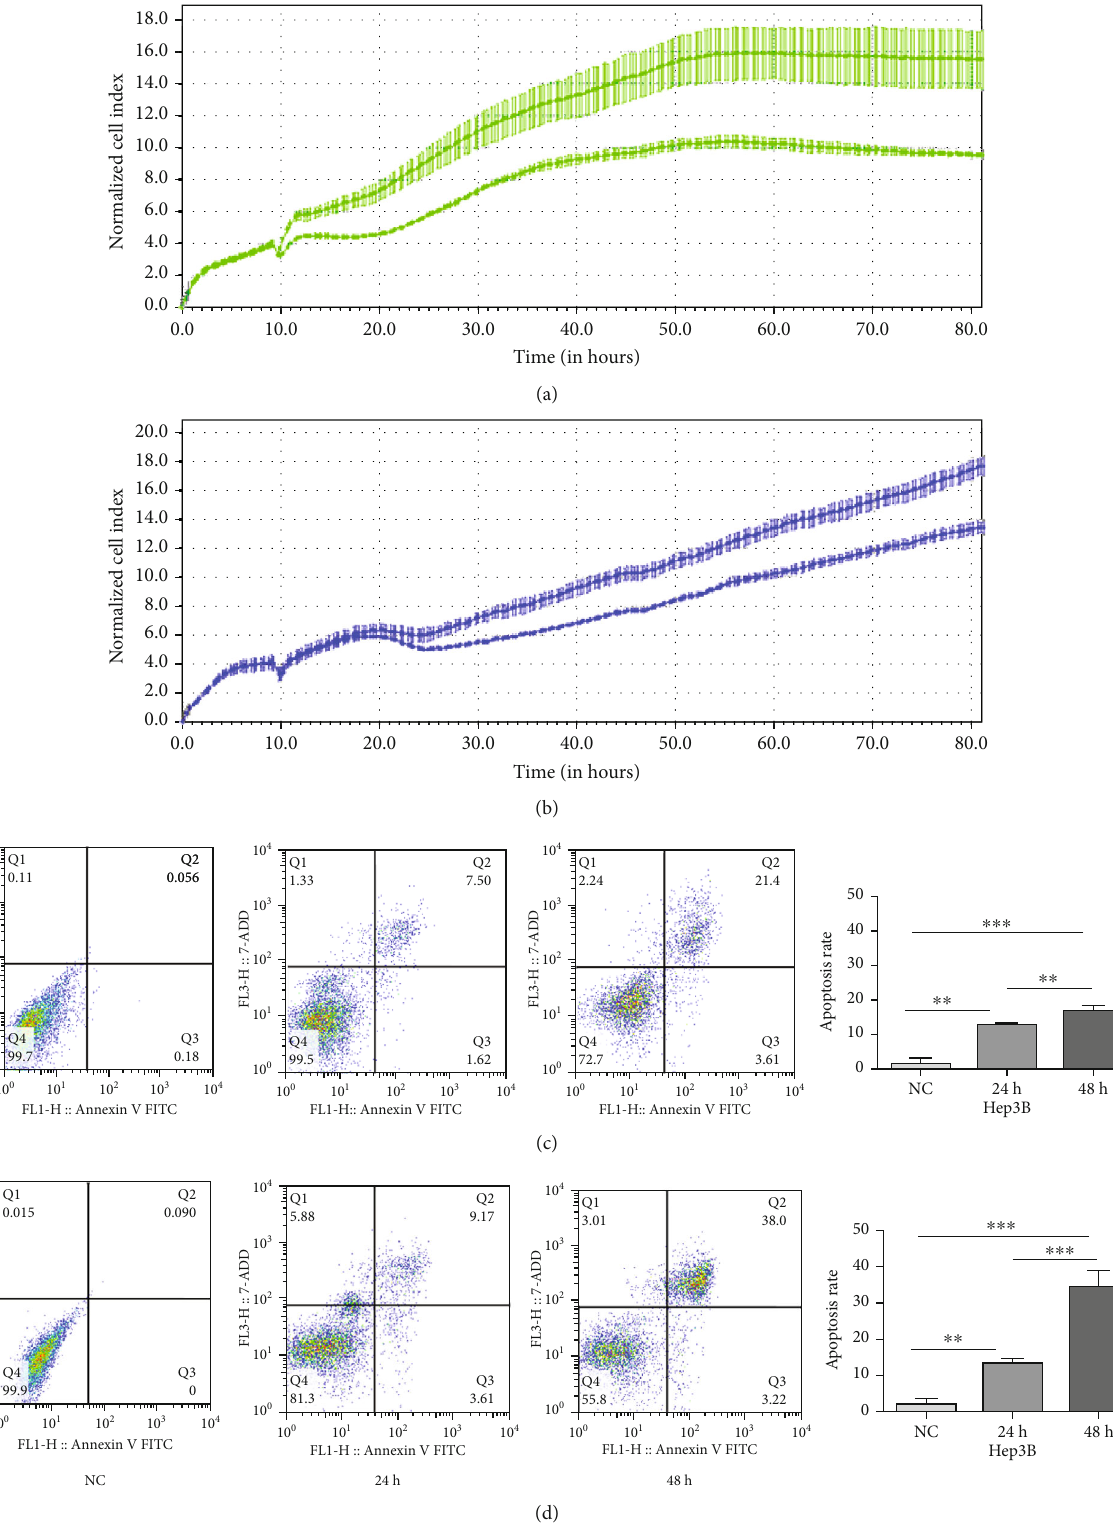
Figure 2: FO can inhibit cell proliferation and stimulate apoptosis in Huh7 cells. (a, b) Cell index values of Huh7 and Hep3B cells cultivated for 90 h. Electrical impedance was measured throughout the cultivation period at a 15min frequency. Green and blue curves represent the proliferation of Huh7 and Hep3B cells treated with DMSO and FO, respectively. The mean cell index values with SE for the three repetitions in each group. (c, d) Hep3B and Huh7 cells were treated with DMSO for 24 hours, FO for 24 hours and 48 hours, and then stained with Annexin V and